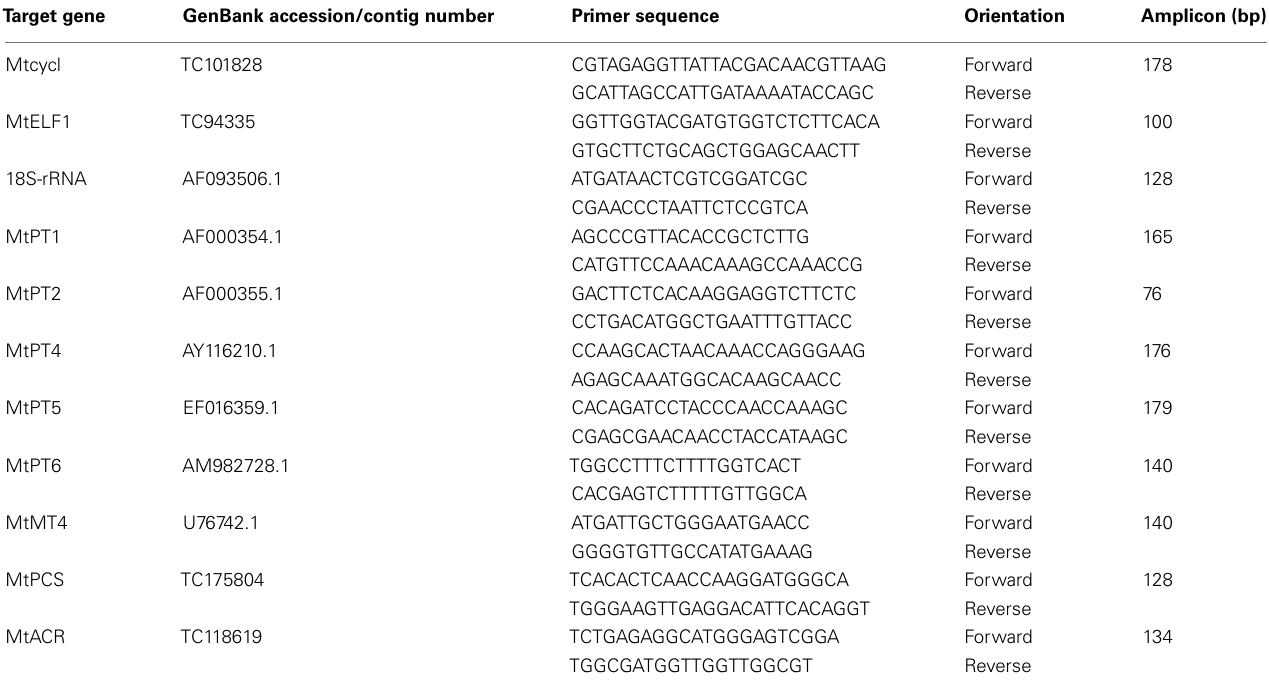
Table 2 | Details of primers used in Quantitative real-time PCR analysis of gene expression in medic ( Medicago truncatula ).